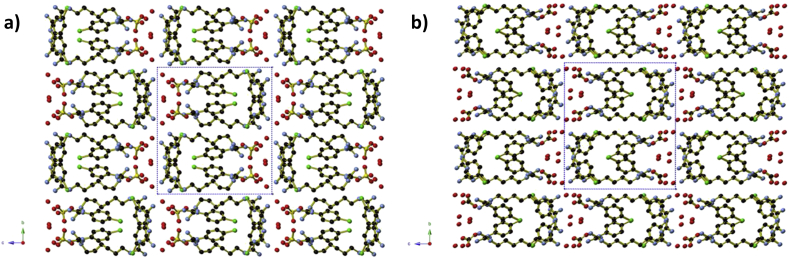
A view along the a-axis of a) (H2CHx)(SO4)·3H2O and b) (H2CHx)(CO3)·4H2O, showing the structural similarities between the two compounds.